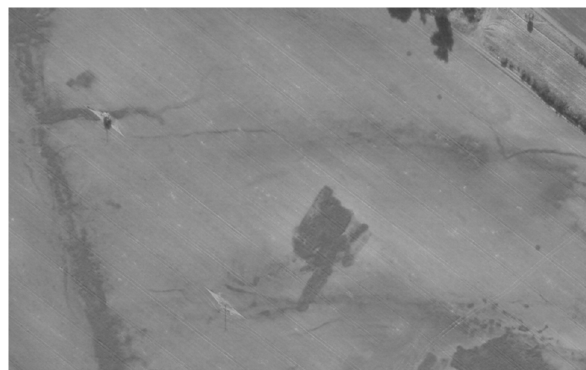
Figure 5. Deforested area